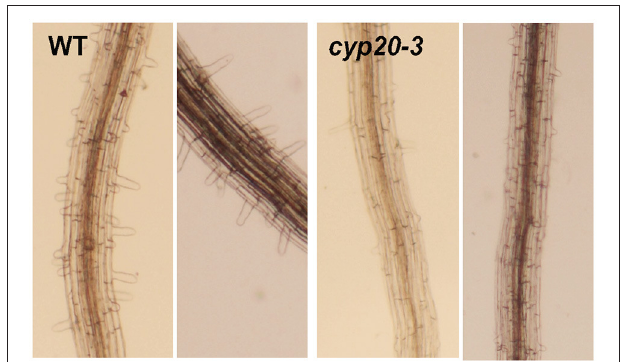
FIGURE 2 | Important roles of OPDA signaling in root morphogenesis. OPDA signaling mutant Arabidopsis ( cyp20-3 ) demonstrated the impairment of root hair